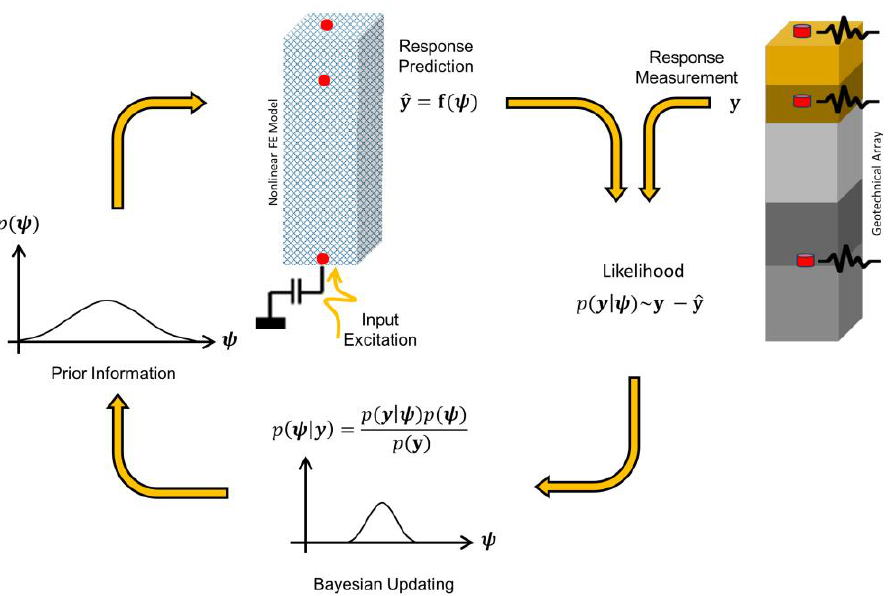
Figure 2. Sequential Bayesian estimation method for joint model and input identification ( 𝝍 ) using finite element prediction ( 𝒚̂ ) and measured responses ( 𝒚 ).